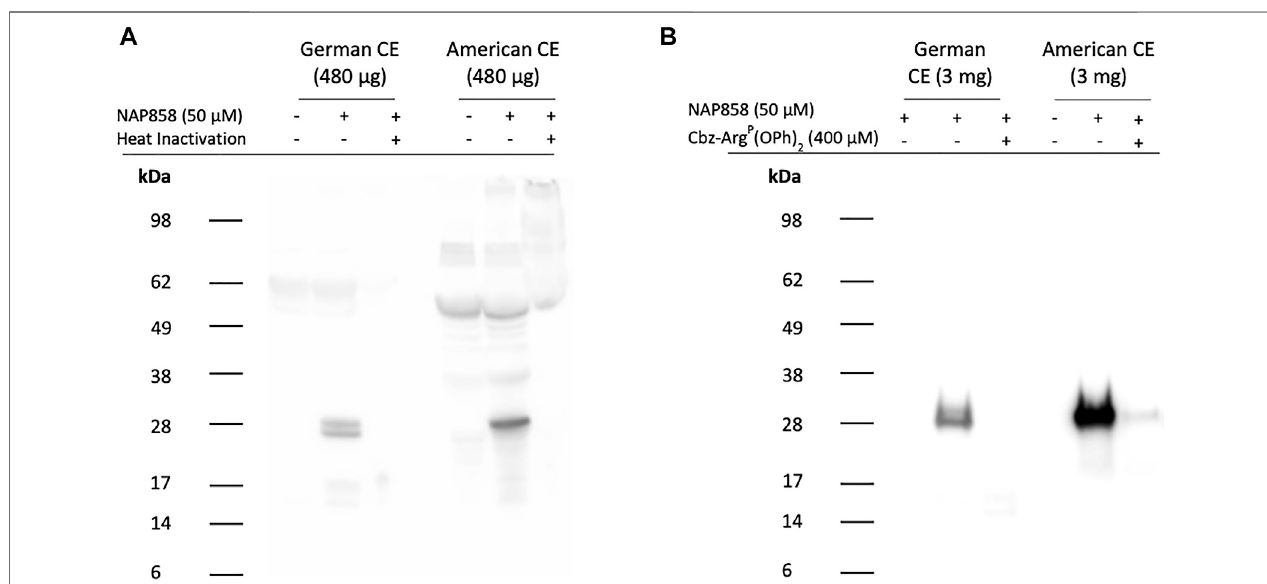
FIGURE 12 | ABP of cockroach extracts for trypsin-like proteases using NAP858 (A) Cockroach extract (480 μ g) was treated (±) with NAP858 (± heat inactivation at 95 ° C, for 10 min), for 30 min, at 37 ° C or (B) cockroach extract (3 mg) was pretreated with neutroavidin agarose beads to remove endogenous biotinylated proteins andthesupernatantprobed(±)withNAP858(±Cbz-Arg P (OPh) 2 ),for30 min,at37 ° C.Puri fi cationofthelabelledproteinswasachievedbyincubationwithafreshbatchof washedneutravidinagarosebeads.BoundproteinswereextractedfrombeadsusingSDS-containingreducingtreatmentbuffer.Inbothcases (A,B) sampleswere subsequently labelled and visualised using